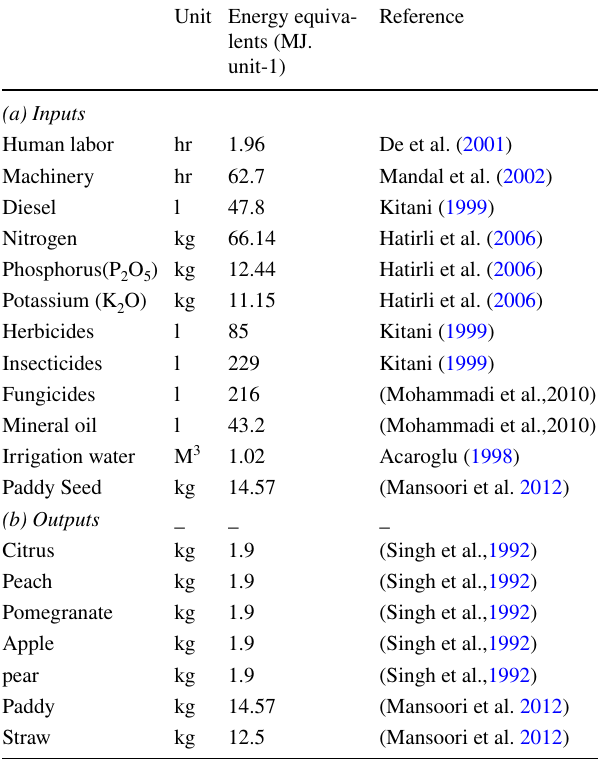
Table 1 Equivalent to input and output energy in the production of studied products in the Tajan plain Unit Energy equiva- lents